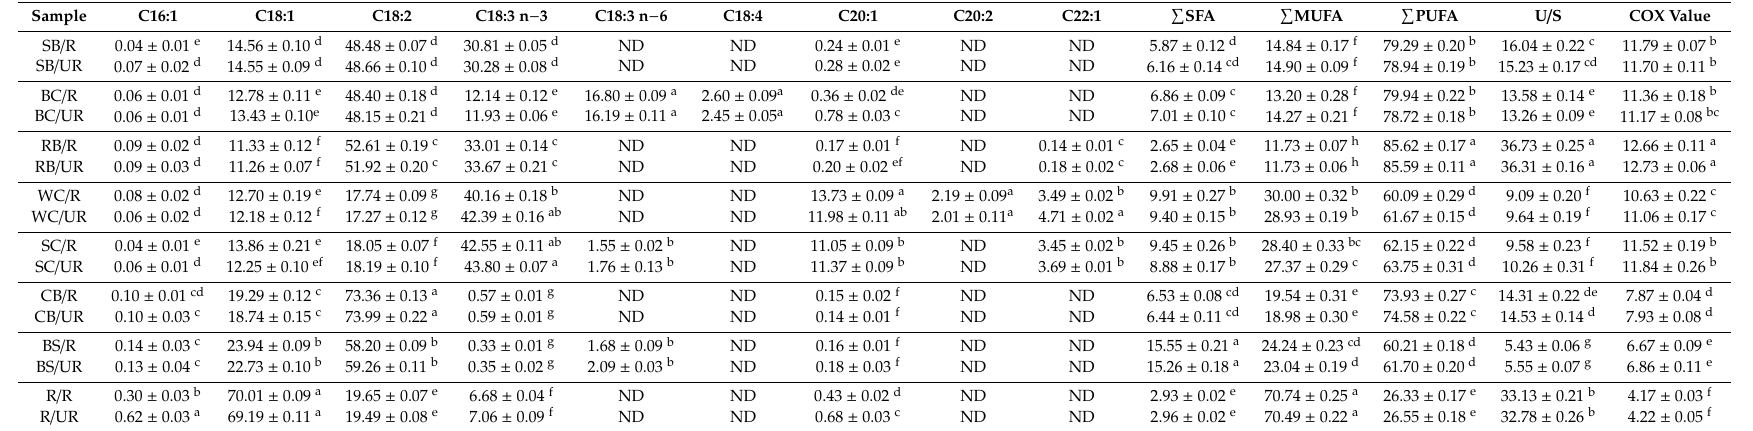
Table 1. Unsaturated fatty acid composition of cold-pressed oils from unroasted and roasted seeds [% w /